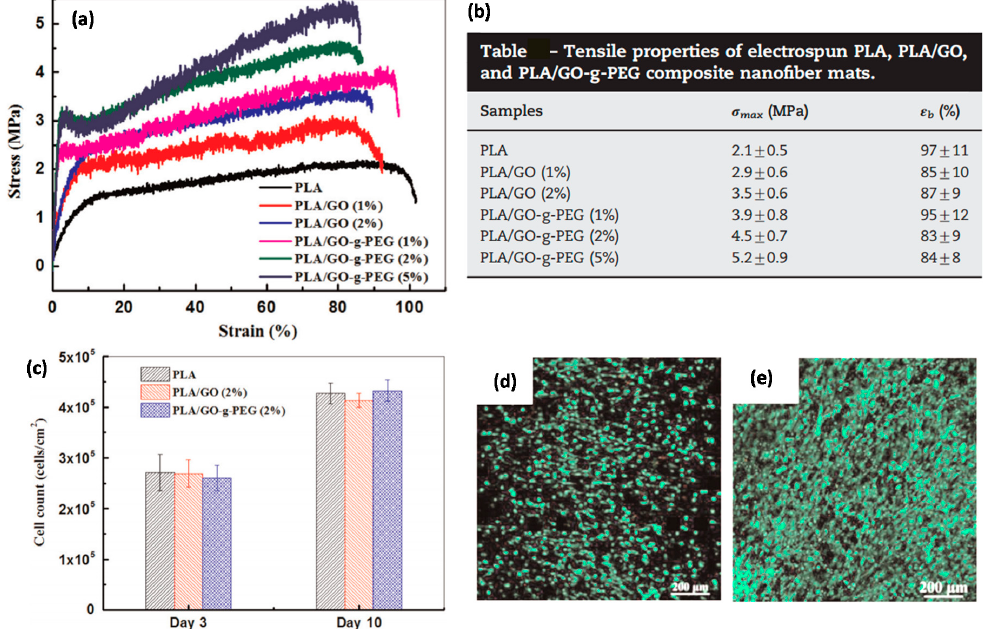
Figure 27. ( a ) Typical stress–strain curves of electrospun PLA, PLA/GO, and PLA/GO- g -PEG composite nanofiber mats; ( b ) Table demonstrating elastic modulus ( σ max ) and elongation at break values ( ε b ); ( c ) Proliferation cell counts of NIH 3T3 cells on scaffolds after 3 and 10 days of culture. Fluorescence micrographs of stained cells showing live (green) and dead (red) cells on PLA/GO-g-PEG (2%) scaffolds after ( d ) 3 and ( e ) 10 days of culture [86].